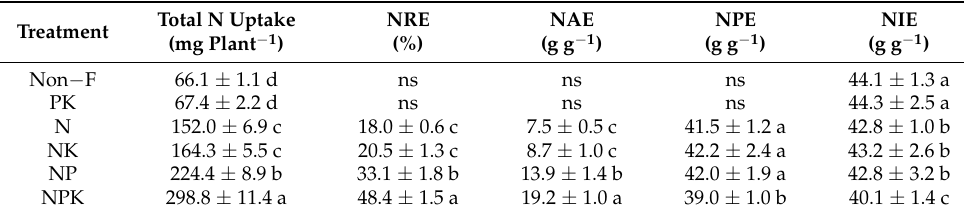
Table 3. Total N uptake per plant, apparent NRE, agronomic N use efficiency (NAE), physiological N use efficiency (NPE), and internal N use efficiency (NIE) for rice plants at 102 d after transplanting.